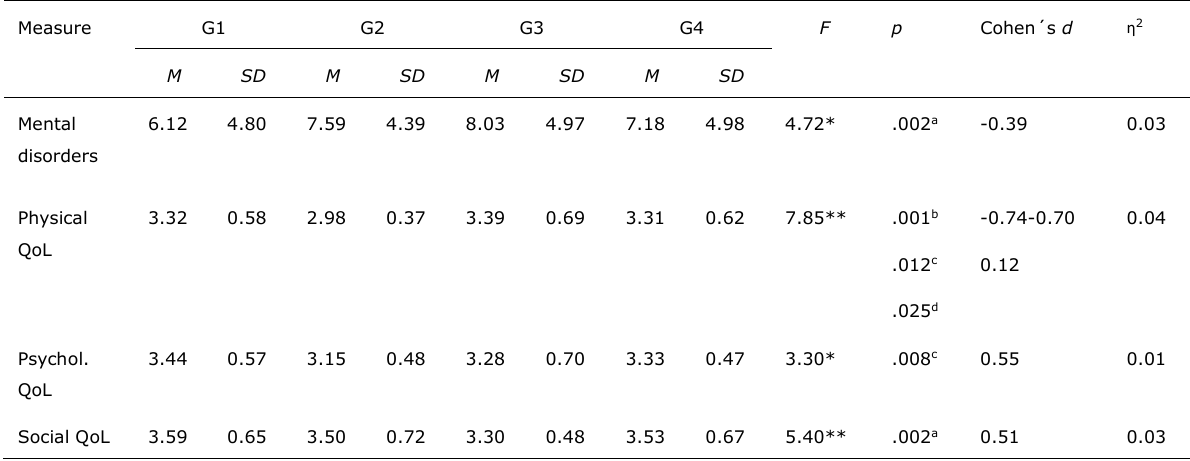
Table 3. Means, standard deviations and one-way analysis of variance in mental disorders and quality of life